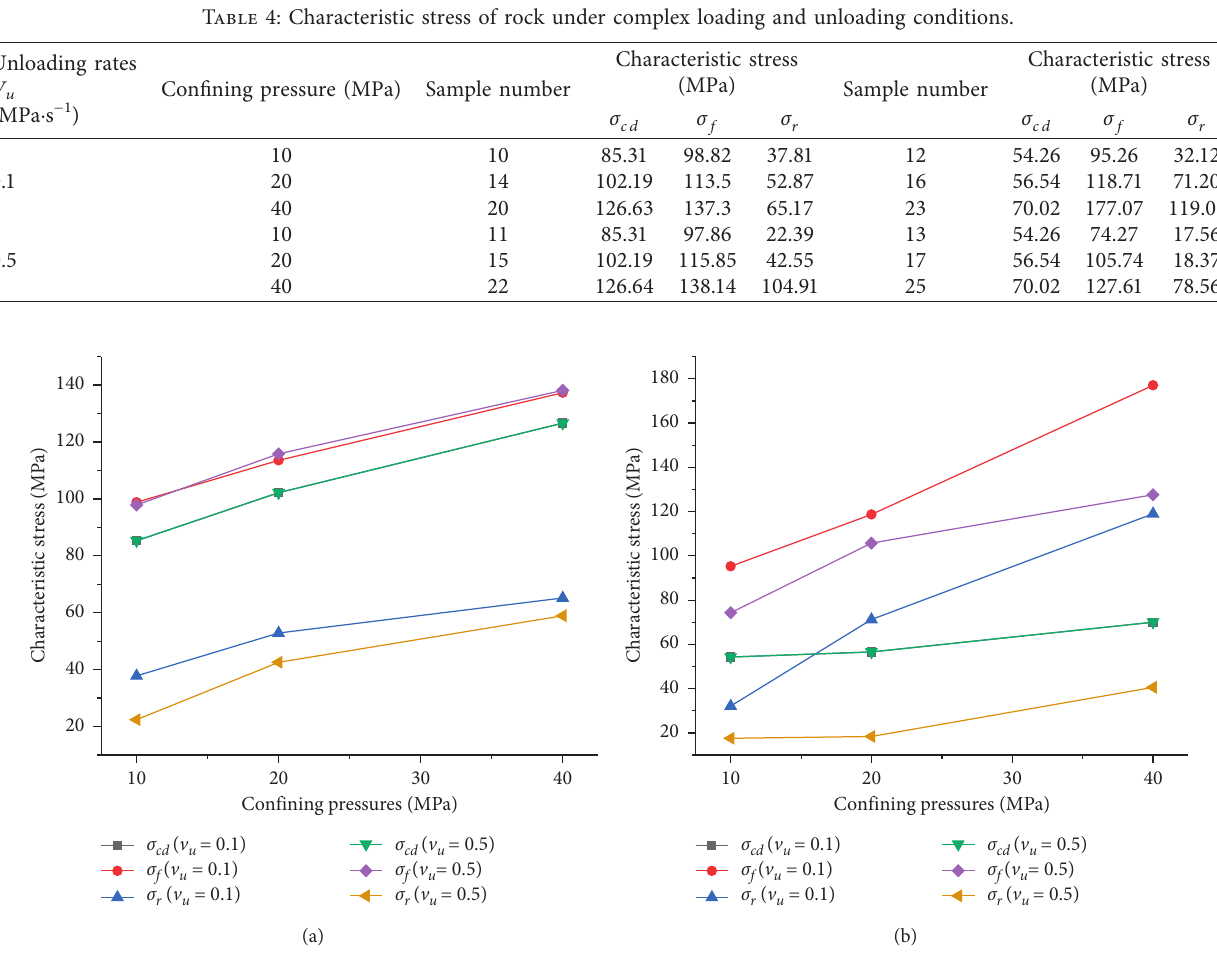
Figure 9: Affection laws of characteristic stress under complex loading and unloading conditions: (a) unloading triaxial test; (b) unloading confining-loading axial pressure test.